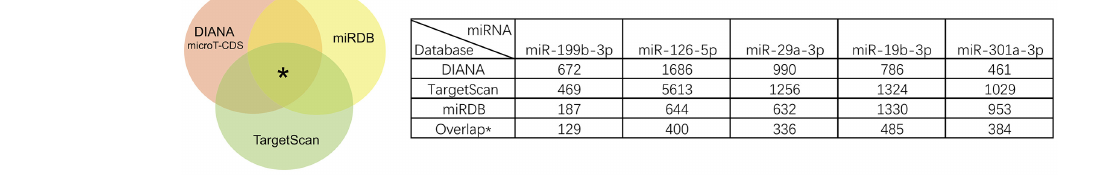
FIGURE 4 | Summary results of the consensus of targets genes of top five miRNAs.